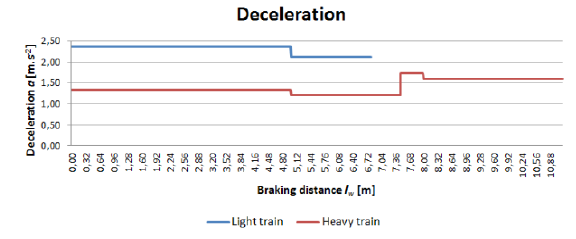
Figure 4. Deceleration rate along the braking dis- tance (Example